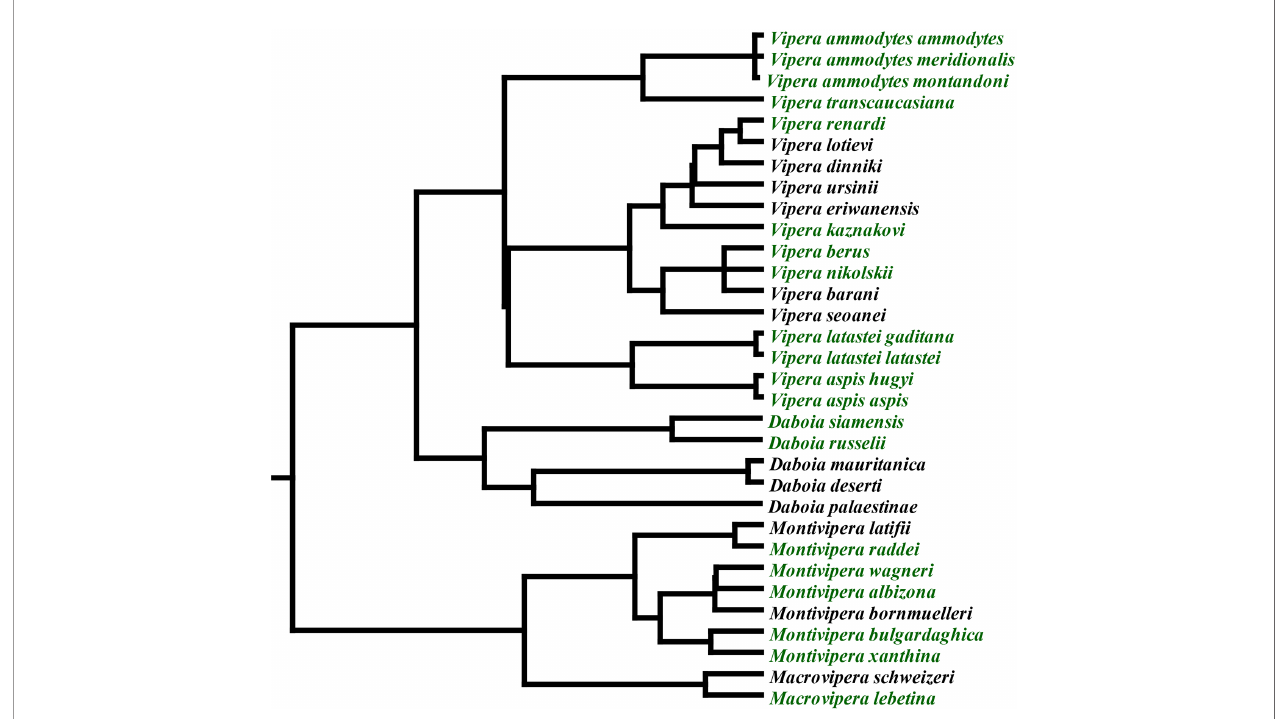
FIGURE 1 | Phylogenetic relationships of Palearctic vipers (14). Green indicates species included in this